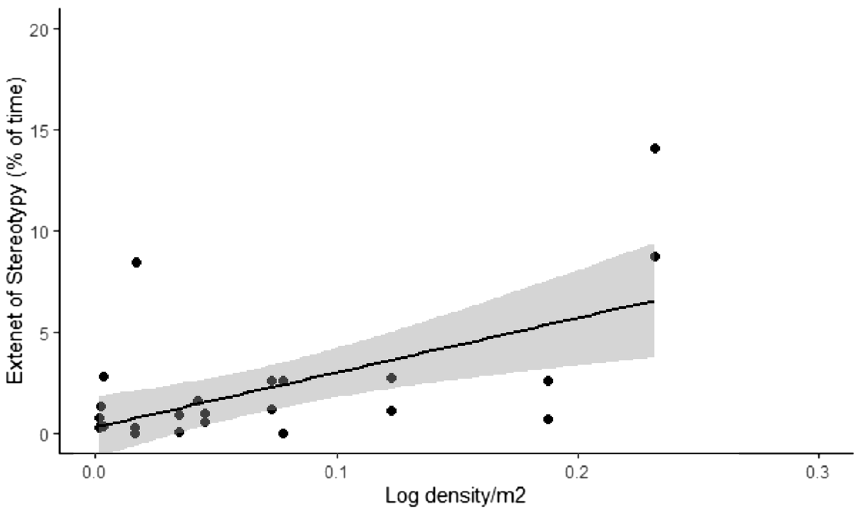
Figure 1. Relation between stereotypy and log density on ground in captive red pandas in Indian zoos. The grey ribbon indicates standard